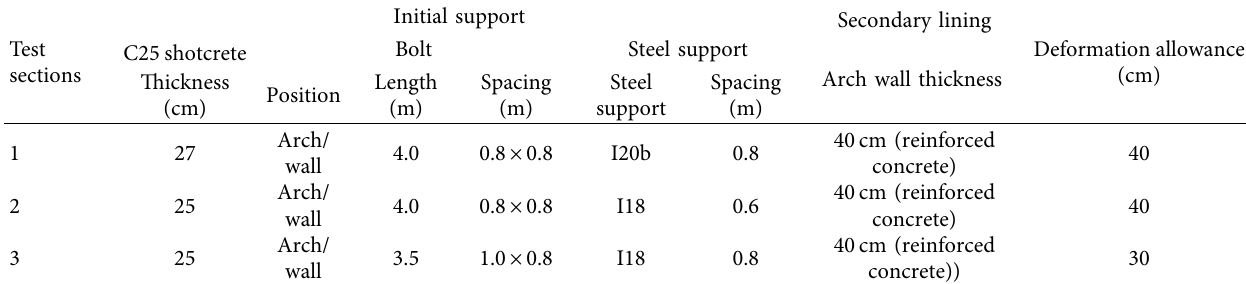
Table 1: Support parameters of three test